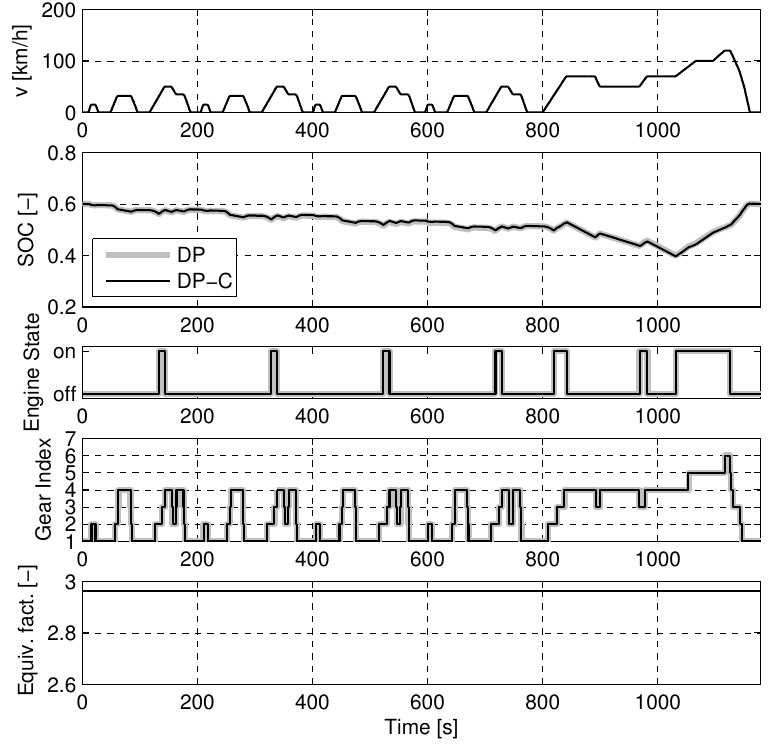
Figure 7. Comparison of the results obtained with DP and the DP-C algorithm on the New European Driving Cycle ((NEDC) driving cycle.